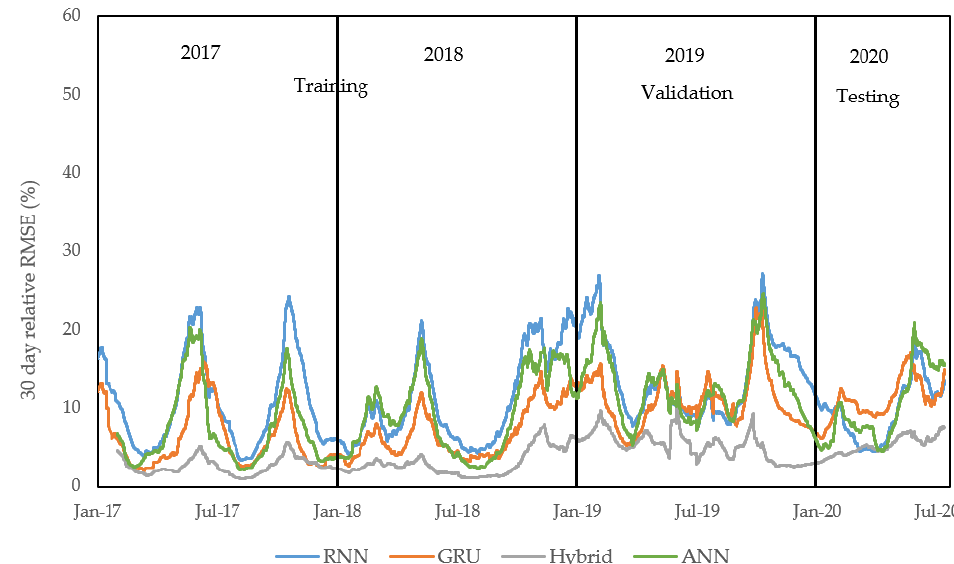
Figure 11. 30-day relative RMSE of the hybrid model compared to three neural network models.